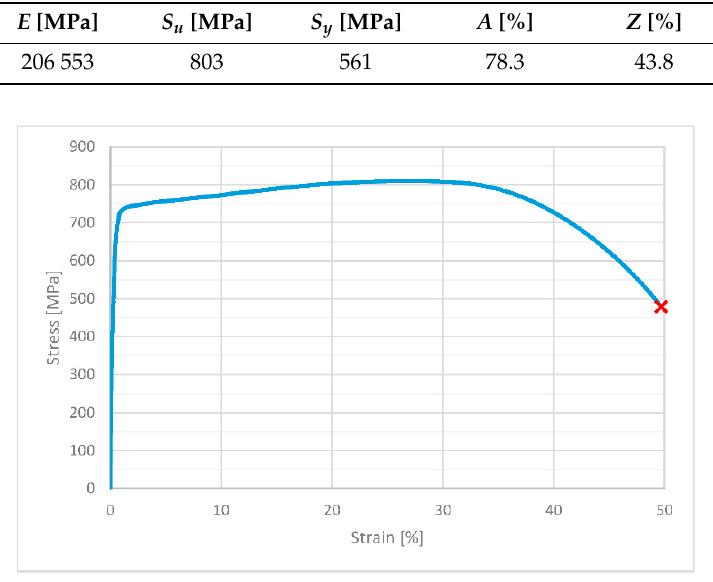
Figure 3. Stress–strain curve for static load for exemplary specimen.